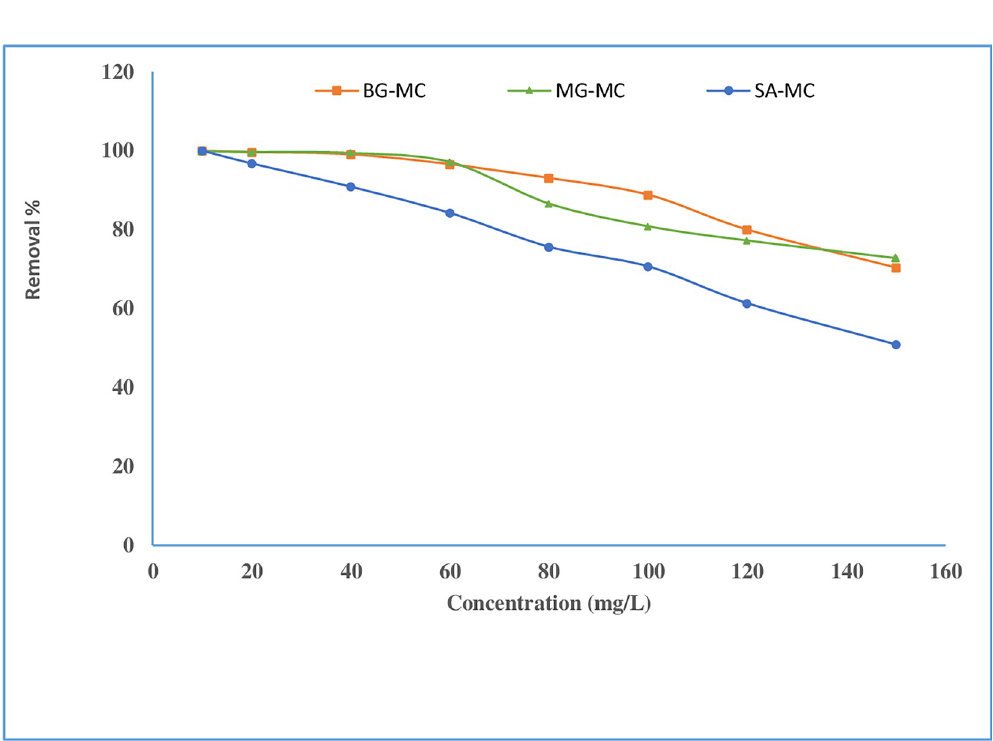
Fig 7. Effect of concentration on adsorption of BG, MG, and SA onto